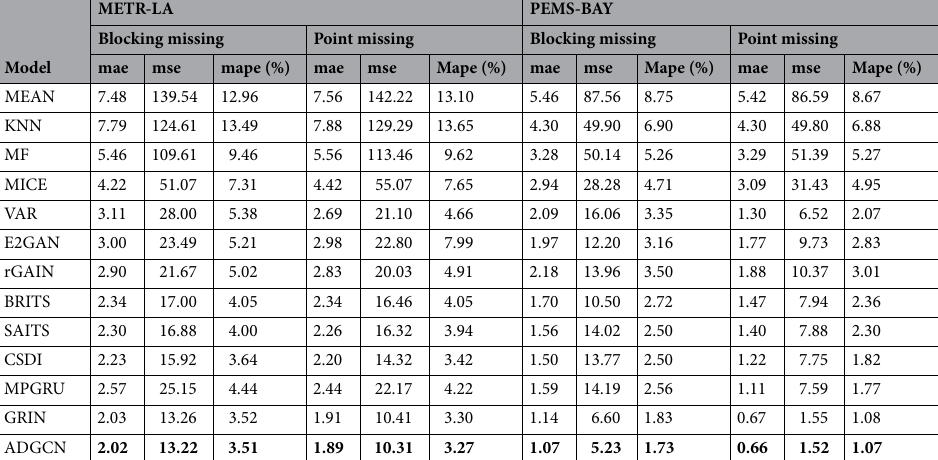
Table 3. Comparison of model performance for an average of 5 experimental fills on the traffic flow domain dataset. The best results are in bold.